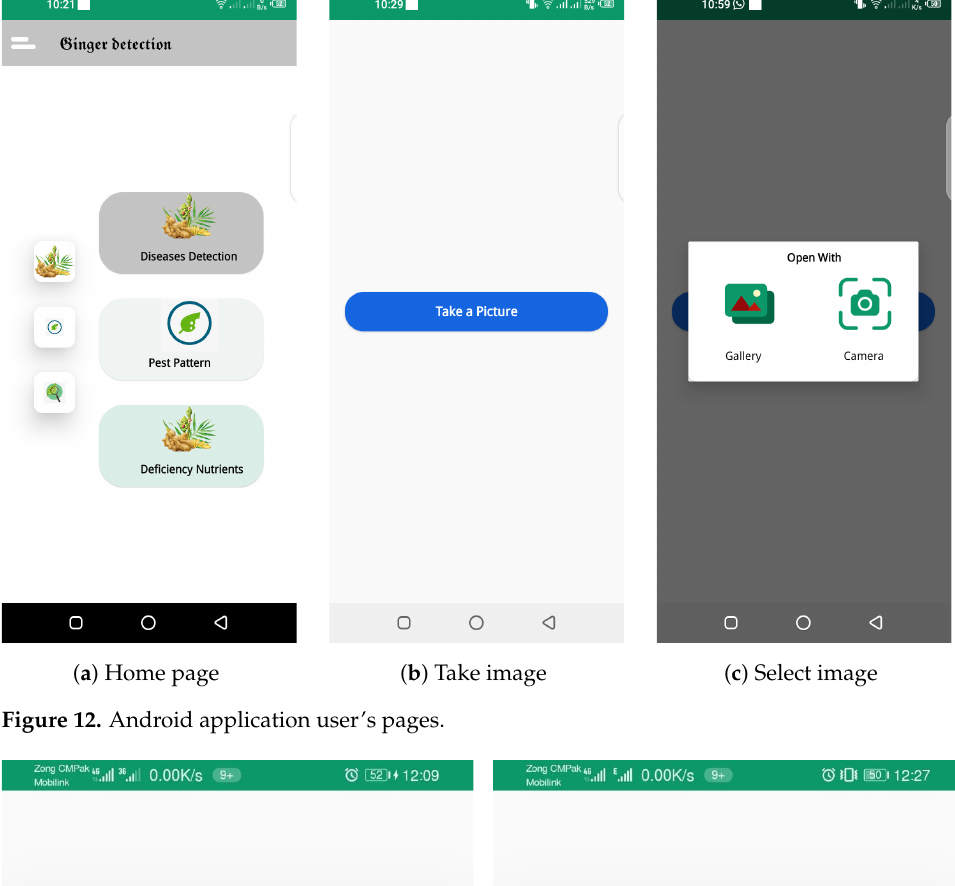
Figure 12. Android application user’s pages.